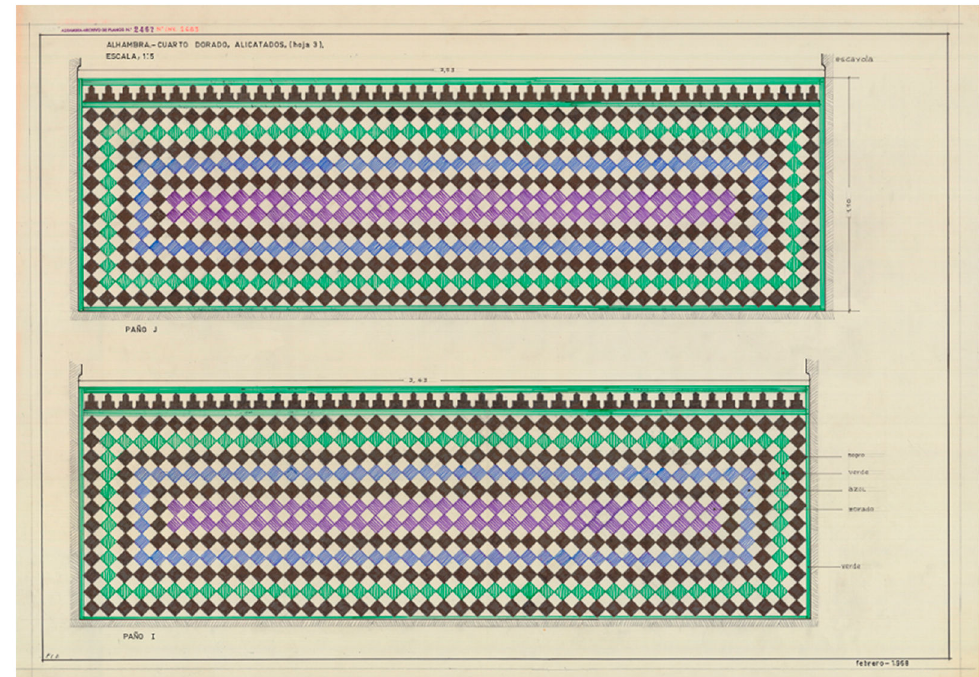
Figure 26. Drawings of the refurbished ceramic dadoes east and west walls of the Cuarto Dorado. Fernando L ó pez D í az de la Guardia, February 1968. © Archivo del Patronato de la Alhambra y Generalife, Photograph Collection, P-002683.